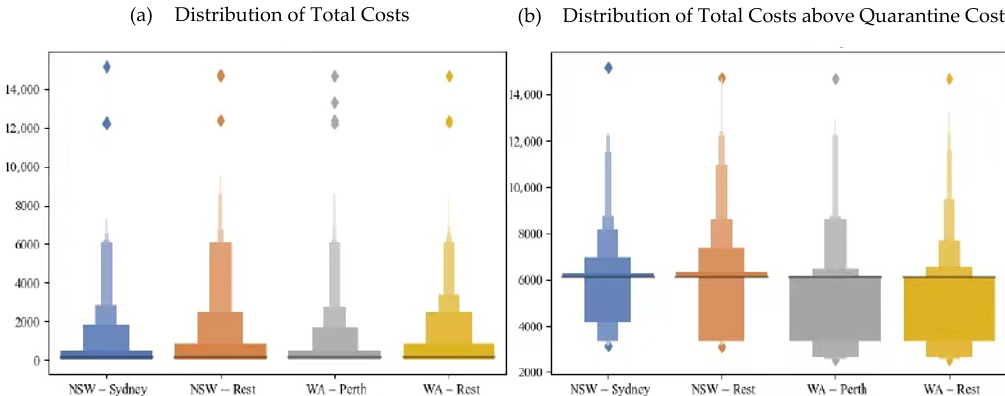
Figure 5. Distribution of total costs of home isolation: ( a ) when the household size is greater than one; and ( b ) when the total cost is greater than the states’ hotel quarantine cost. Hotel quarantine costs announced by NSW and WA are AU$3000 and AU$2520, respectively.